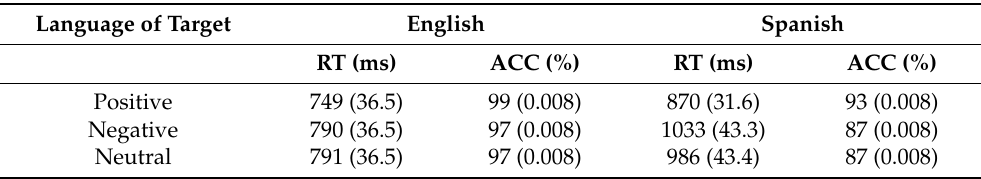
Table 4. Means of response latencies in milliseconds and accuracy results (percentage of correct responses; SE in parentheses) for Spanish and English emotion words recorded in the lexical decision task (LDT).